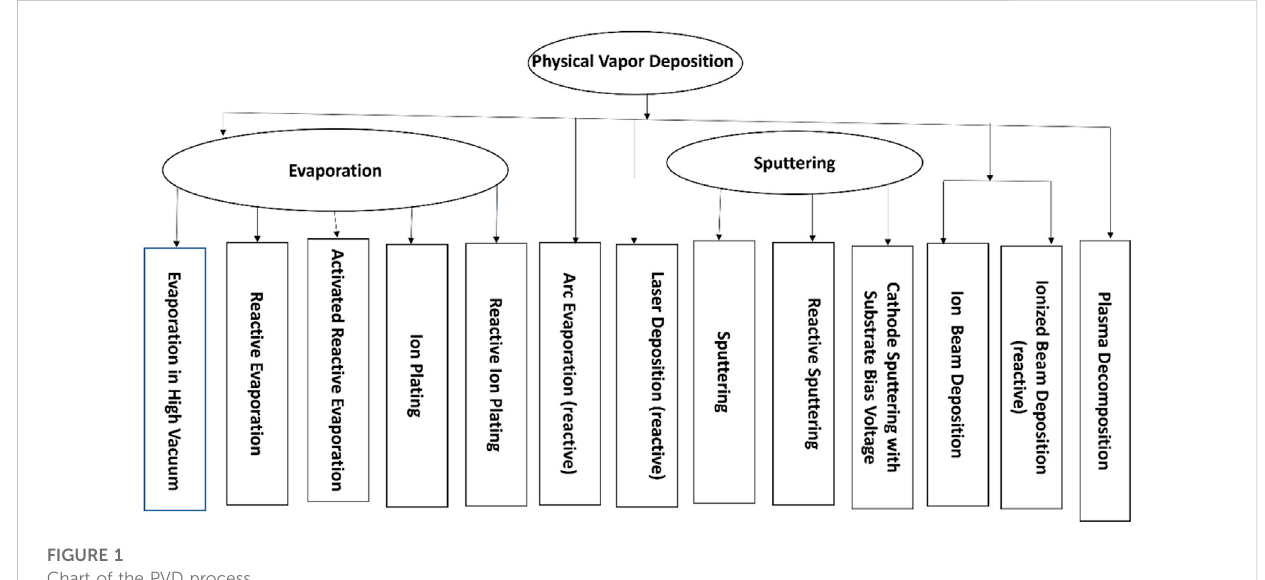
FIGURE 1 Chart of the PVD process.